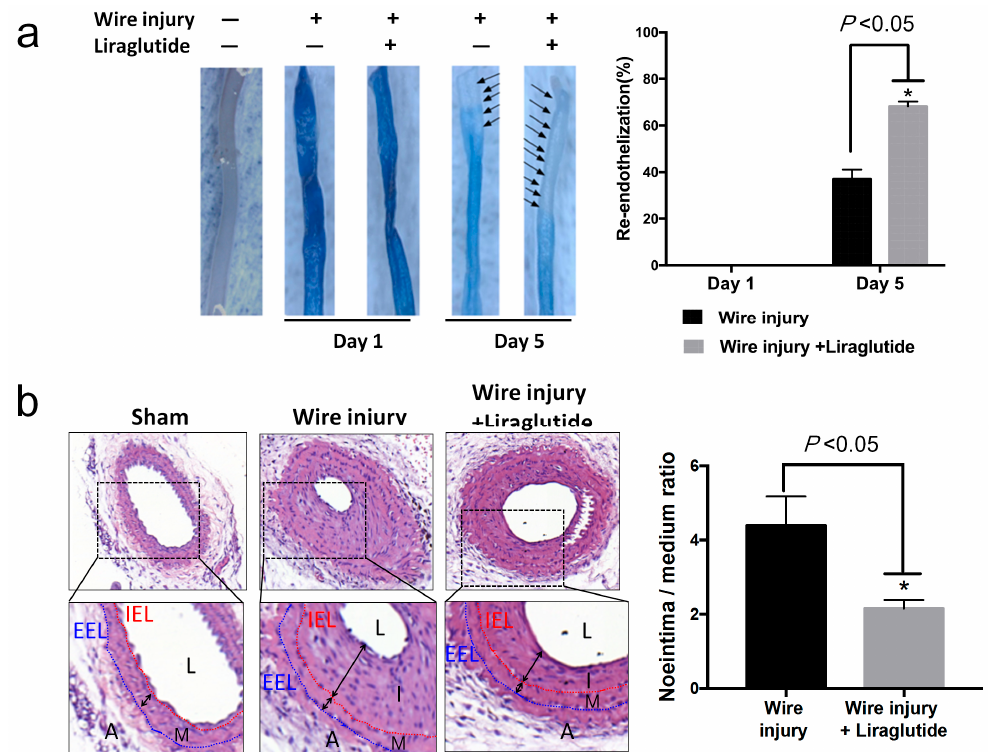
Figure 1. Liraglutide promotes endothelium recovery and reduces neointima formation in wire-injured carotid arteries of diabetic mice. Streptozotocin (STZ)-induced diabetic C57BL/6 mice were subjected to a wire-induced carotid artery injury with or without liraglutide treatment. ( a ) The percentage of the area of re-endothelisation was determined after the systemic injection of Evans blue at day one and day five ( n = 3 per group). The stained blue area corresponds to the area with poor re-endothelialisation. The black arrowheads point at the area without blue staining area, which indicated re-endothelialised cells. Data are shown as mean ± SEM. * P < 0.05 analyzed by Student’s t -test. ( b ) The right common carotid arteries were collected on day 28 post-injury for haematoxylin and eosin (H and E) staining to evaluate the severity of neointima formation between groups. Data are shown as the mean ± SD (all groups, n = 10 per group), * P < 0.05 analyzed by Student’s t -test. IEL, internal elastic lamina;